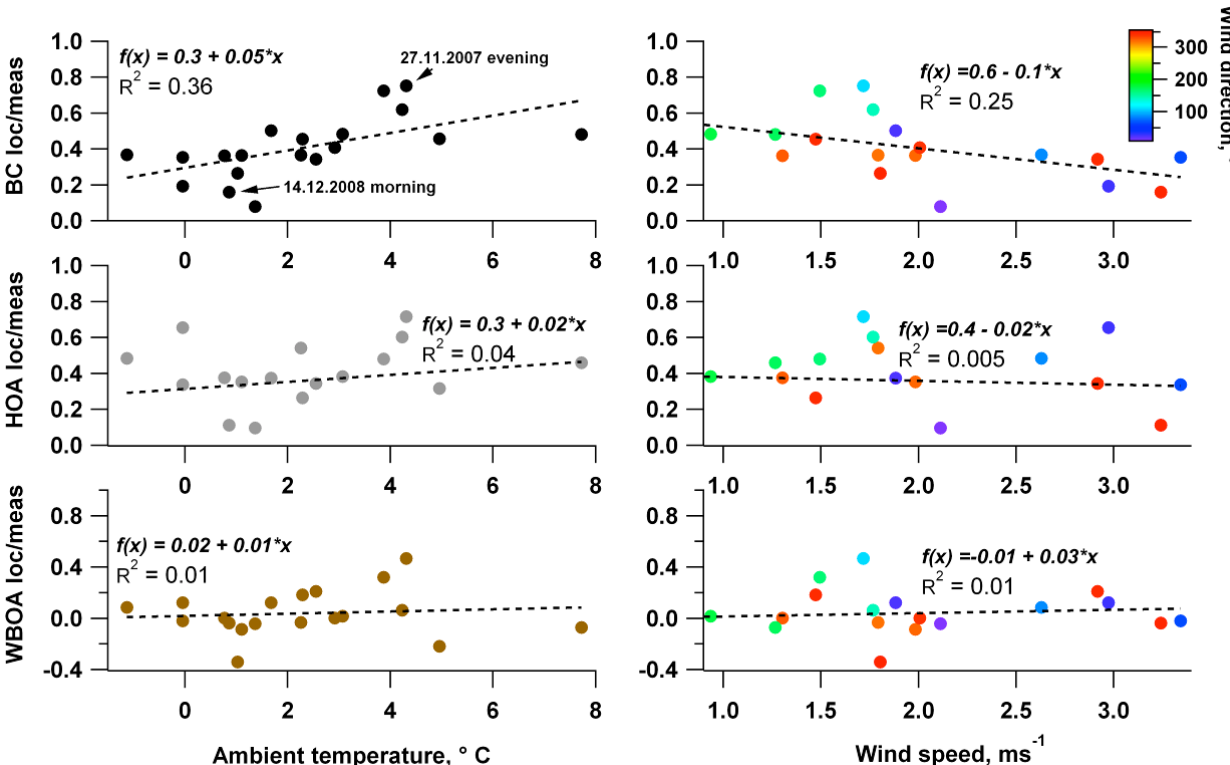
Figure 10: Ratios of local contributions to measured concentrations of different components as a function of ambient temperature (left) and wind speed (right). Data points are average values per measurement drive. Wind speed data are colored according to wind direction.